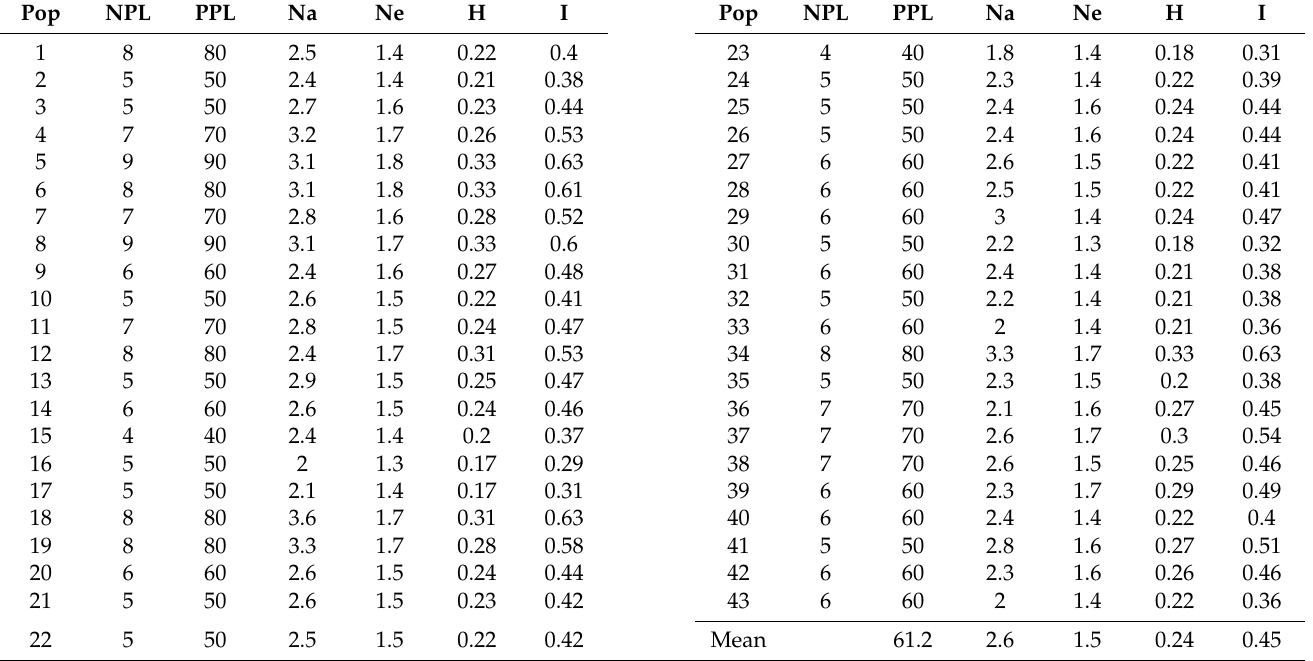
Table 4. Population diversity indices averaged over 10 polymorphic EST-SSR loci for each